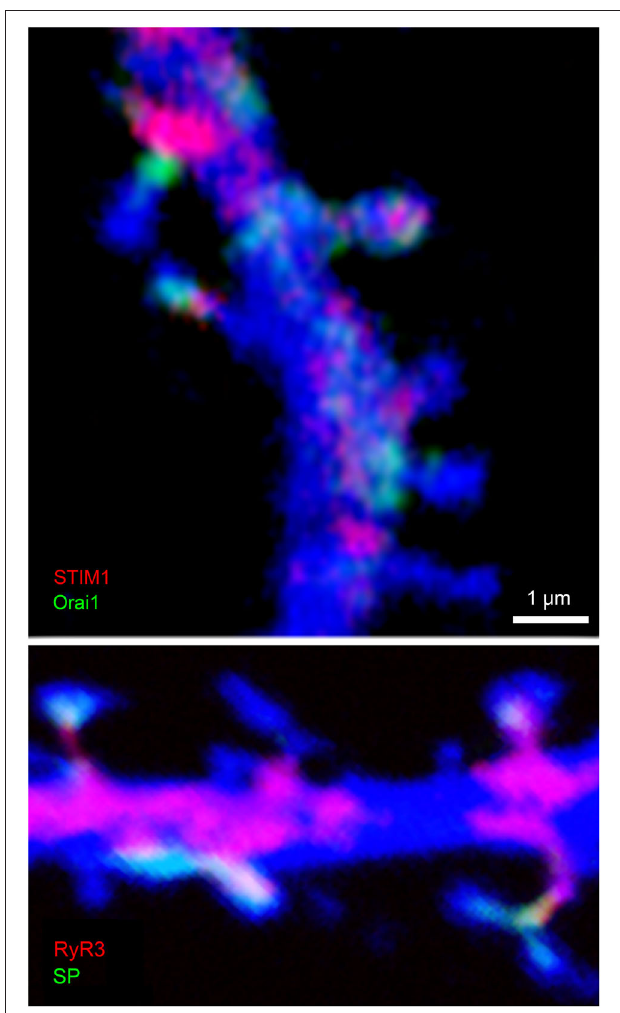
FIGURE 2 | Colocalization of STIM1 and Orai1 (top) and RyR3 and SP (bottom) in cultured hippocampal neurons . Cells were transfected with DsRed to image morphology (blue) and subsequently immunostained for STIM1 (red, top) and Orai1(green), or RyR (red) and SP (green, bottom). Scale 1 µ m for both images. Colocalization of STIM and Orai are obvious in some but not all spines, such that either both or none were immunostained in the dendritic spines. Similarly, RyR and SP were colocalized in some but not all dendritic